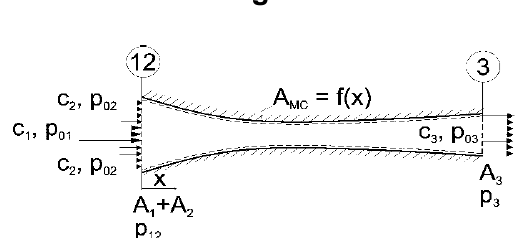
Fig. 1. Control volume of a mixing